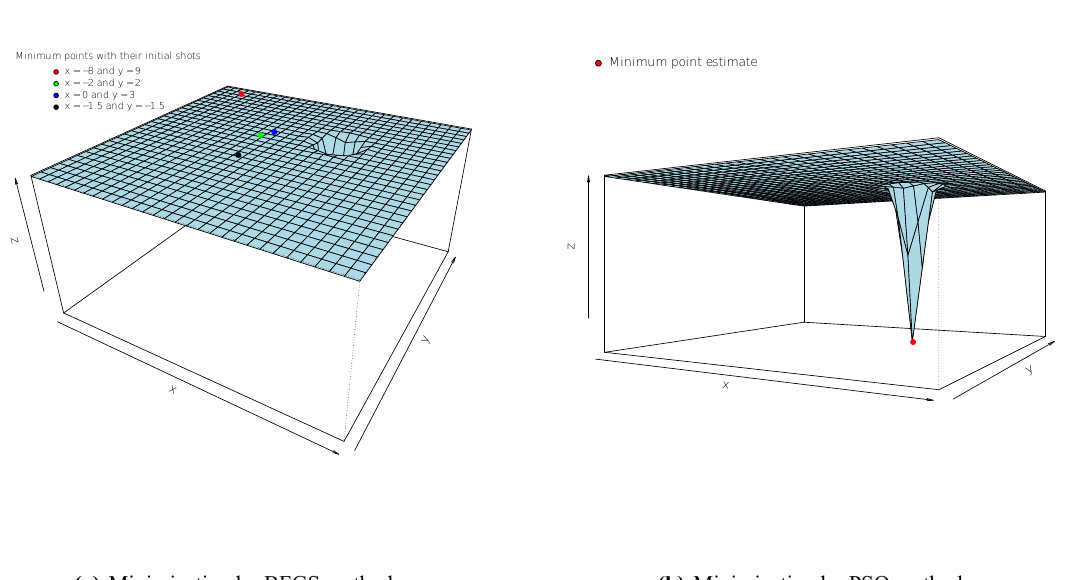
Figure 3 - Points of minimum obtained by optim and pso functions by using BFGS and PSO